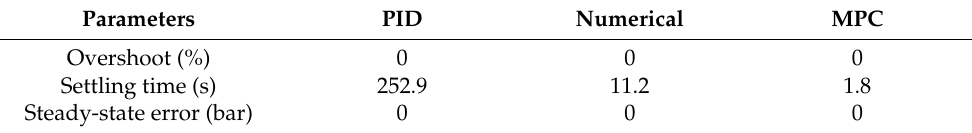
Table 2. Comparison of PID, numerical, and MPC performance in terms of the pressure variable. Parameters PID Numerical